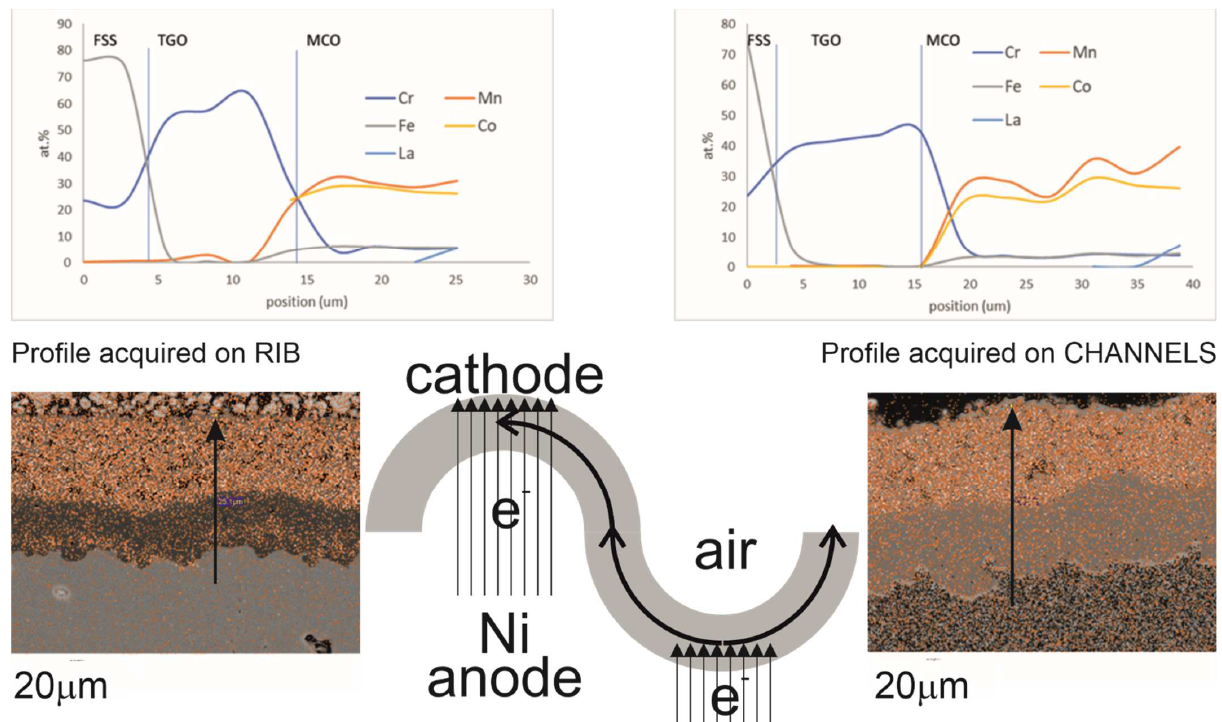
Figure 3. From top-left clockwise: ( a ) the interconnect aspect at the inlet with dark crystals on top of the MCO at the channel; ( b ) SEM-BSE details of the channel with crystals on top; ( c ) EDXS analyses; ( d ) cross-sectional features representative of the three layers (i.e., from top to bottom: surface crys- tals, MCO and